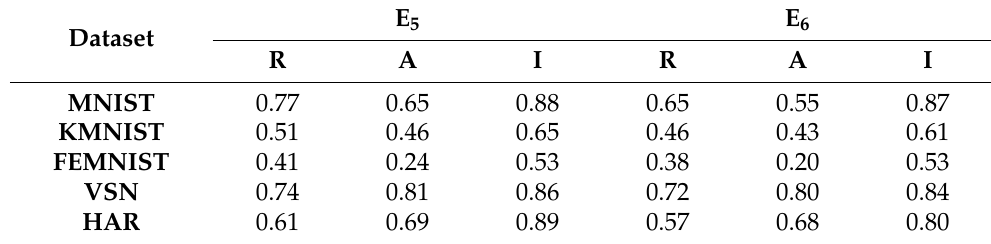
Table 12. Accuracy comparison under severe to extremely severe free rider density environments. FedAvg learning algorithm and Non-IID conditions are used.